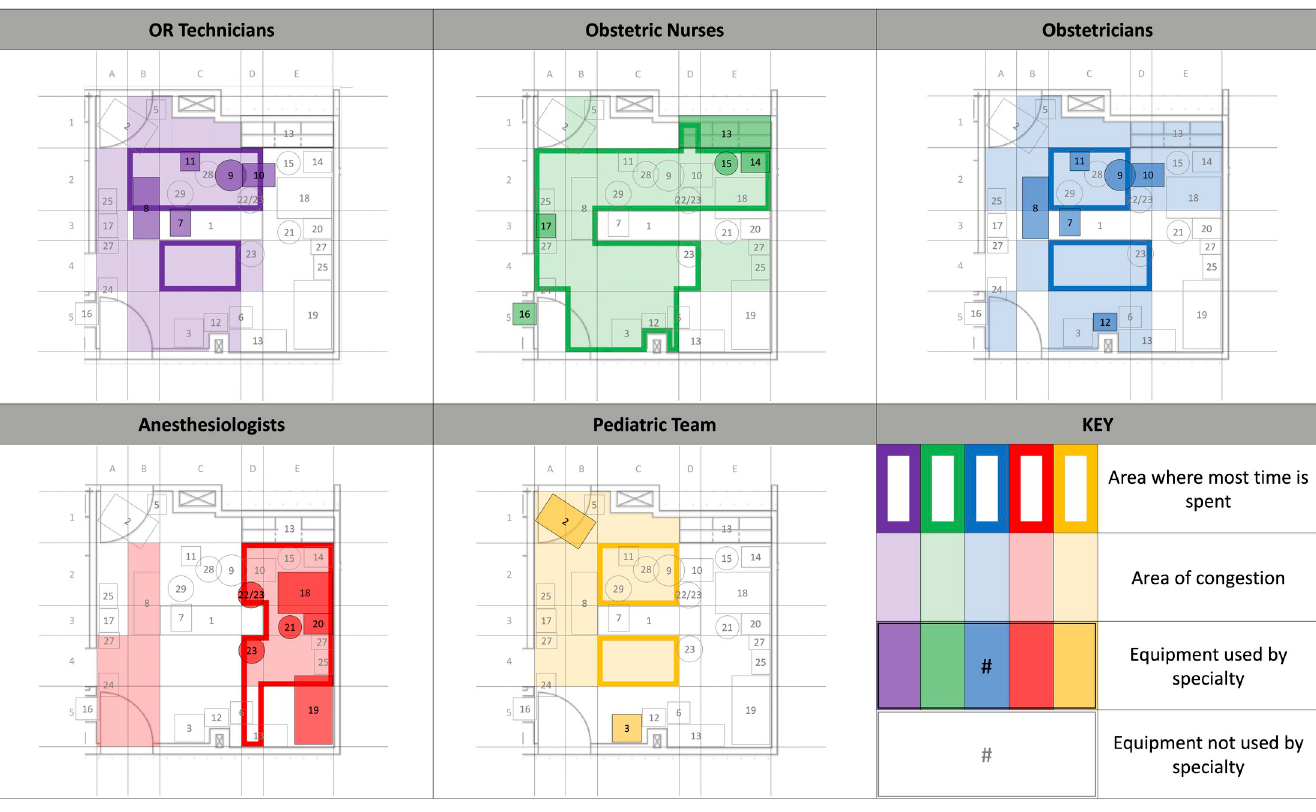
Fig 3. Reported areas of congestion and time spent in OR-B by